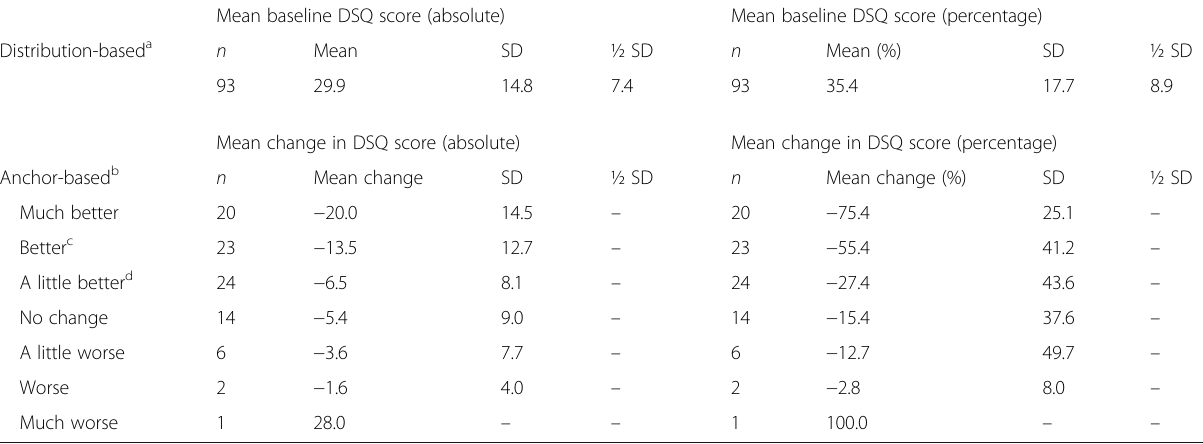
Table 5 Estimates of meaningful change in DSQ score in patients with EoE at baseline and from baseline to week 12 of the treatment period Mean baseline DSQ score